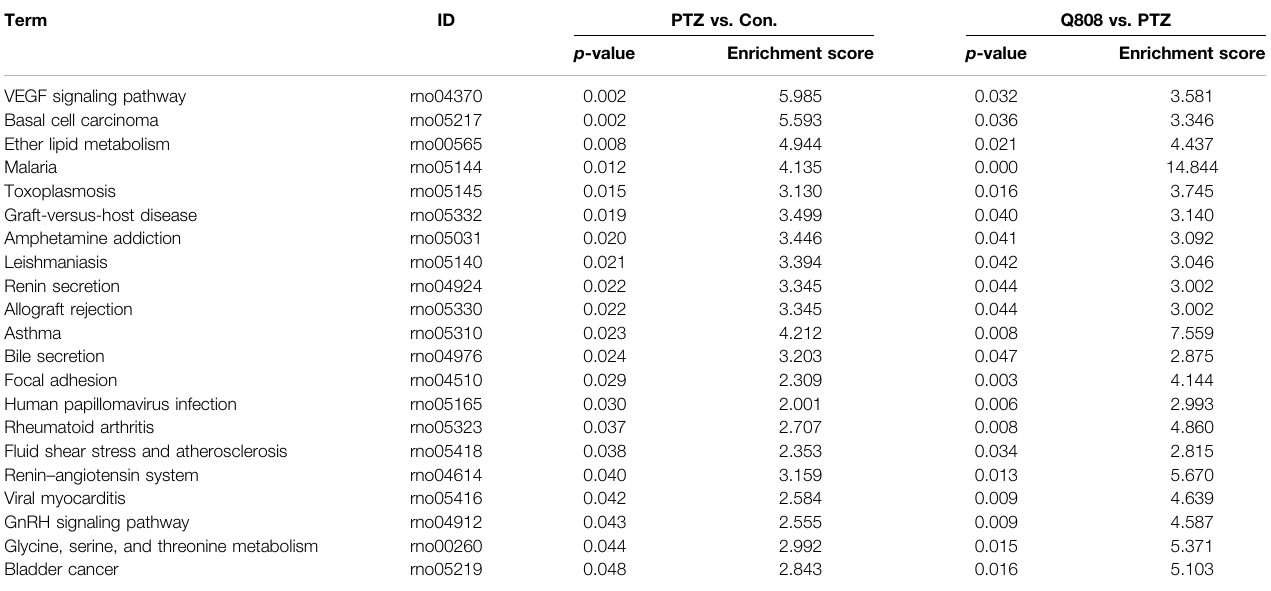
TABLE 3 | Twenty-one hub pathways across the three groups.